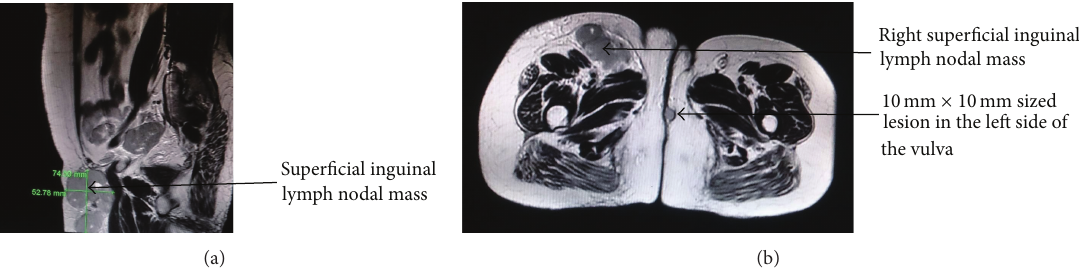
Figure 3: (a) Pretreatment sagittal magnetic resonance (MR) image depicting the superficial inguinal lymph nodal mass measuring 5.3 cm × 7.5 cm in size. (b) Pretreatment axial MR image showing the primary vulvar lesion and the right superficial inguinal lymph nodal mass.